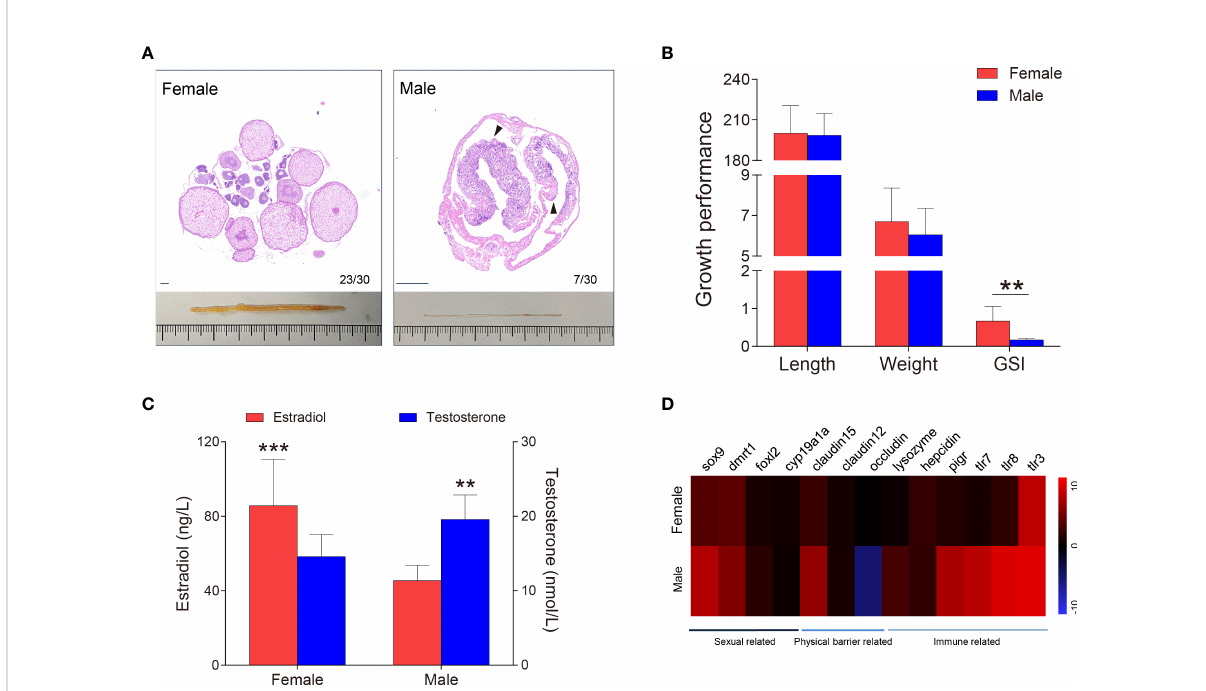
FIGURE 2 Sex identi fi cation of M. albus . (A) Representative histology graphs (upper) and morphology (lower) from ovary and testis of M. albus under the same background. Black triangles indicate genital folds. Scale bar, 100 m m. (B) Relationships among body length (mm), weight (g), and GSI (%) of M. albus . (C) Serum concentrations of estradiol (left) and testosterone (right) in female and male M. albus. (D) Heat map depicting the relative expression levels of genes in ovary (n=22) and testis (n=5) tissues. ** P < 0.01, *** P < 0.001, unpaired Student ’ s t -test. The data are expressed as the mean values ± standard deviation